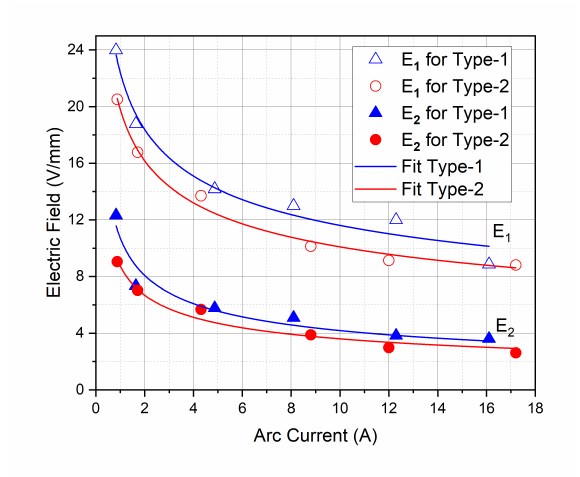
Figure 12. Electric field of the arc regions as a function of arc current.